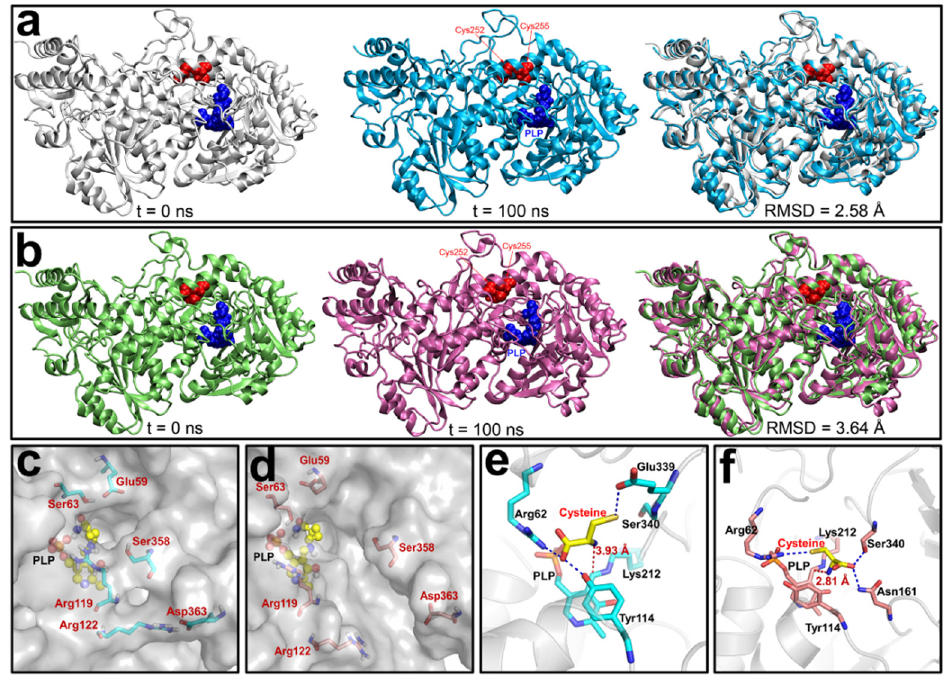
Figure 3. Structural comparison of the reduced and oxidized CSE during molecular dynamics (MD) simulations and molecular docking. ( a ) Snapshot structure of the reduced CSE at t = 0 ns (Left) and t = 100 ns (Center), along with the optimal backbone alignment of the two structures (Right). ( b ) Snapshot structure of the oxidized CSE at t = 0 ns (Left) and t = 200 ns (Center) along with the optimal backbone alignment of the two structures (Right). For clarity, the residues Cys252 and Cys255 in the CXXC motif are colored in red, and the PLP cofactor is colored in blue. ( c , d ) Comparison of the substrate entrance tunnel of the reduced CSE and the oxidized CSE after MD simulations. ( e , f ) Interaction between the substrate L -cysteine and the active center of the reduced and oxidized CSE using molecular docking. The blue dashed line denotes the hydrogen bond, and the red dashed line denotes the distance between the amino group of L -cysteine and the cofactor